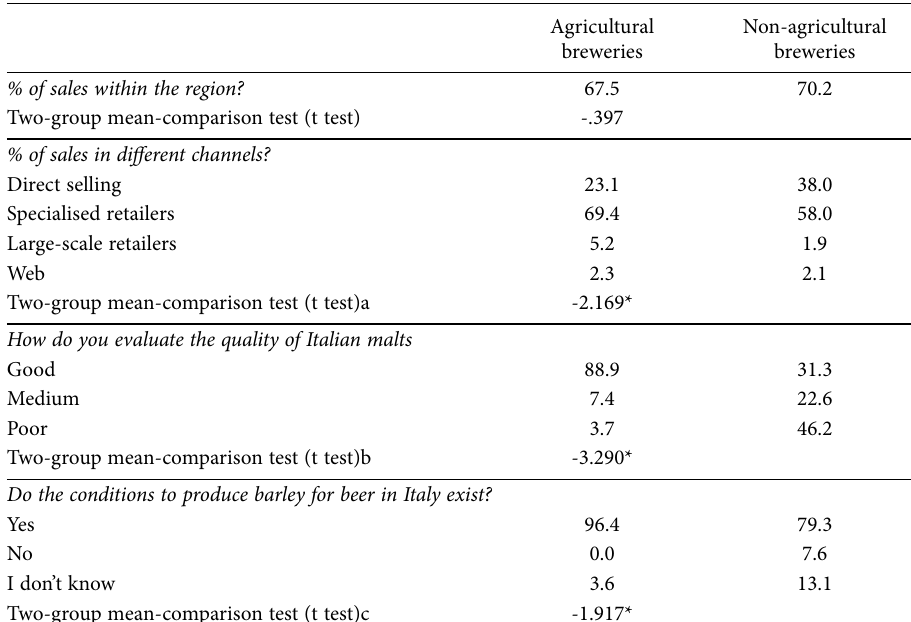
Table 6. Production and marketing choices: comparison between survey responses of agricultural and non-agricultural breweries (% of